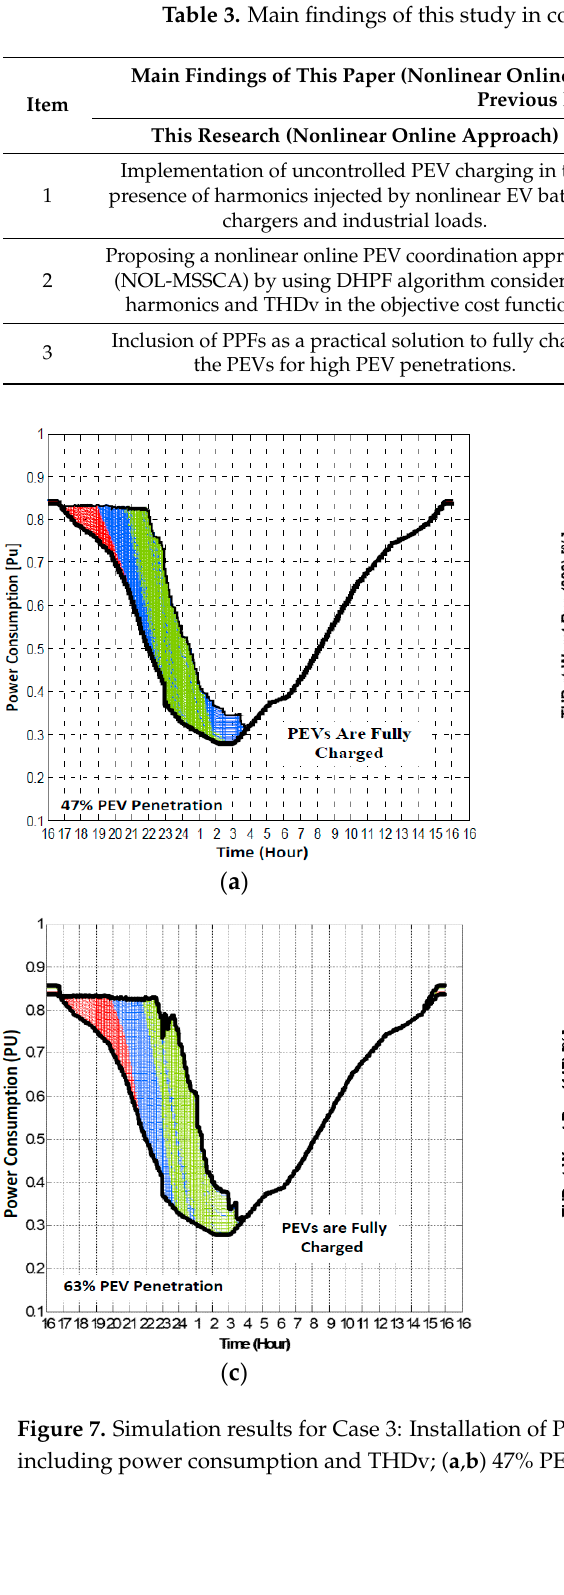
Table 3. Main findings of this study in comparison with previous work.